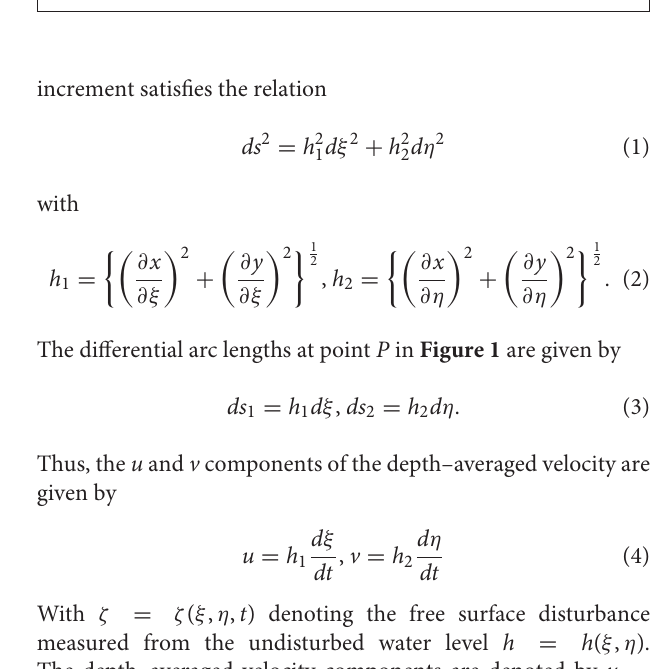
FIGURE 1 | Schematic showing the ξ − η orthogonal curvilinear co–ordinate system employed in the IHRC CEST model.